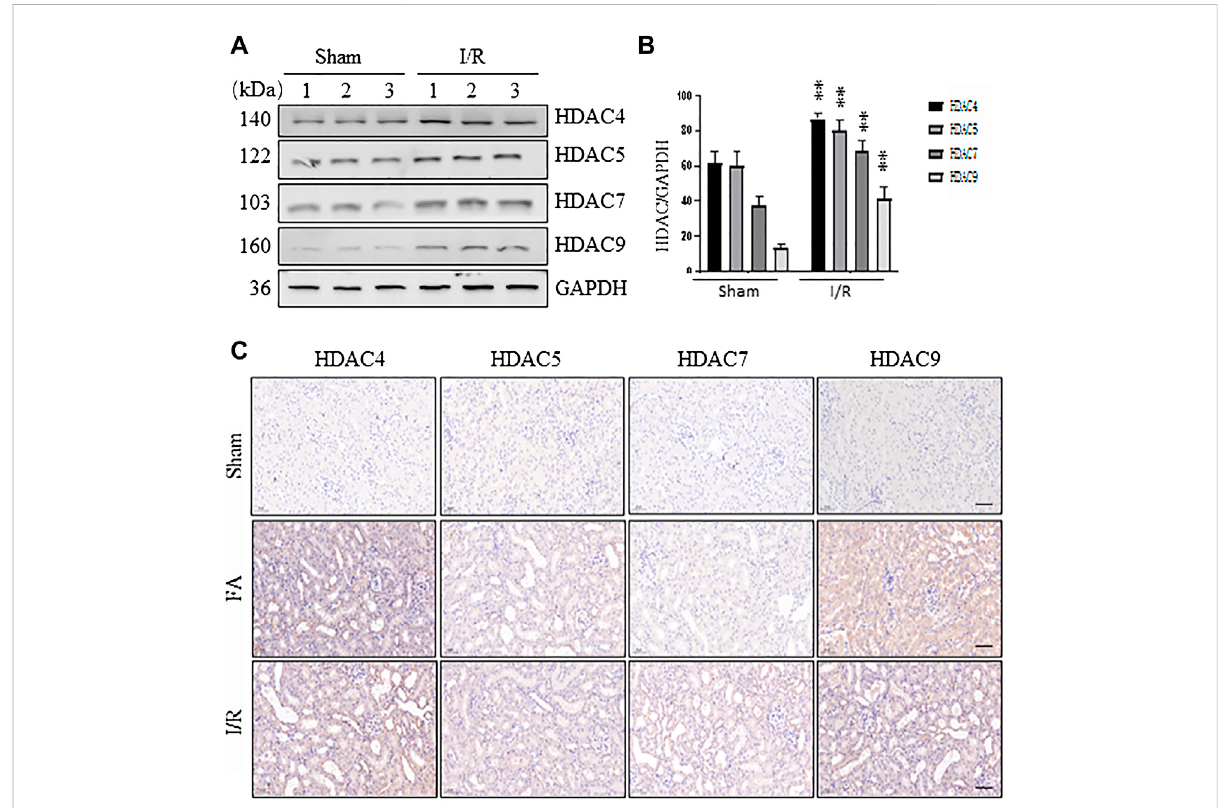
FIGURE 1 Expression of HDAC4, HDAC5, HDAC7, and HDAC9 in the kidney following ischemia/reperfusion (I/R) and folic acid (FA) injury (A) At 48 h after sham operation or I/R, kidneys were collected and tissue lysates were subjected to immunoblot analysis with antibodies against HDAC4, 5, 7, 9, and GAPDH. Representative immunoblots are three samples in each group (B) Expression levels of HDAC4, 5, 7, 9 were quanti fi ed by densitometry and normalized with GAPDH. Data are expressed as means ± SD ( n = 3). ** p < 0.01 (C) At 48 h after sham operation, FA, or I/R, kidneys